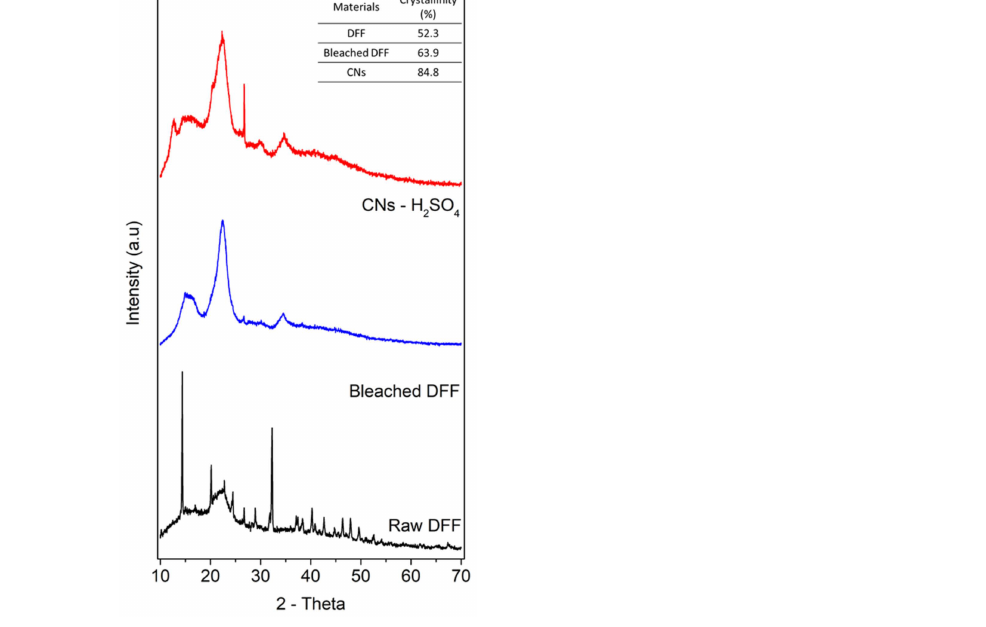
Figure 4. XRD patterns of a raw DFF ( black ), bleached DFF ( blue ) and CN ( red ) samples, an inset table showing the crystallinity index.